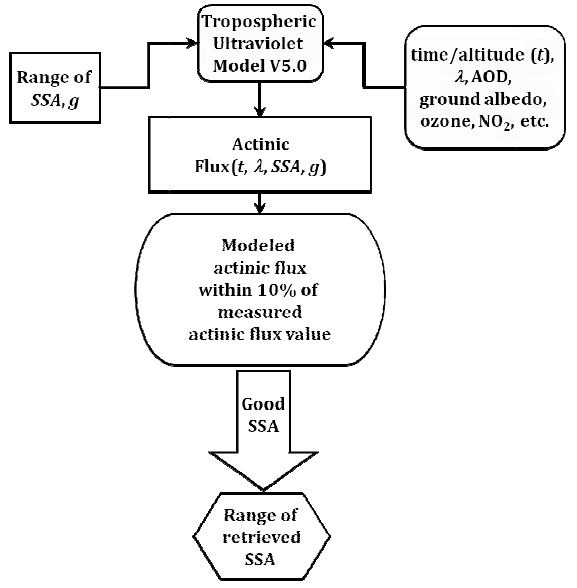
Fig. 1. Schematic of the actinic flux